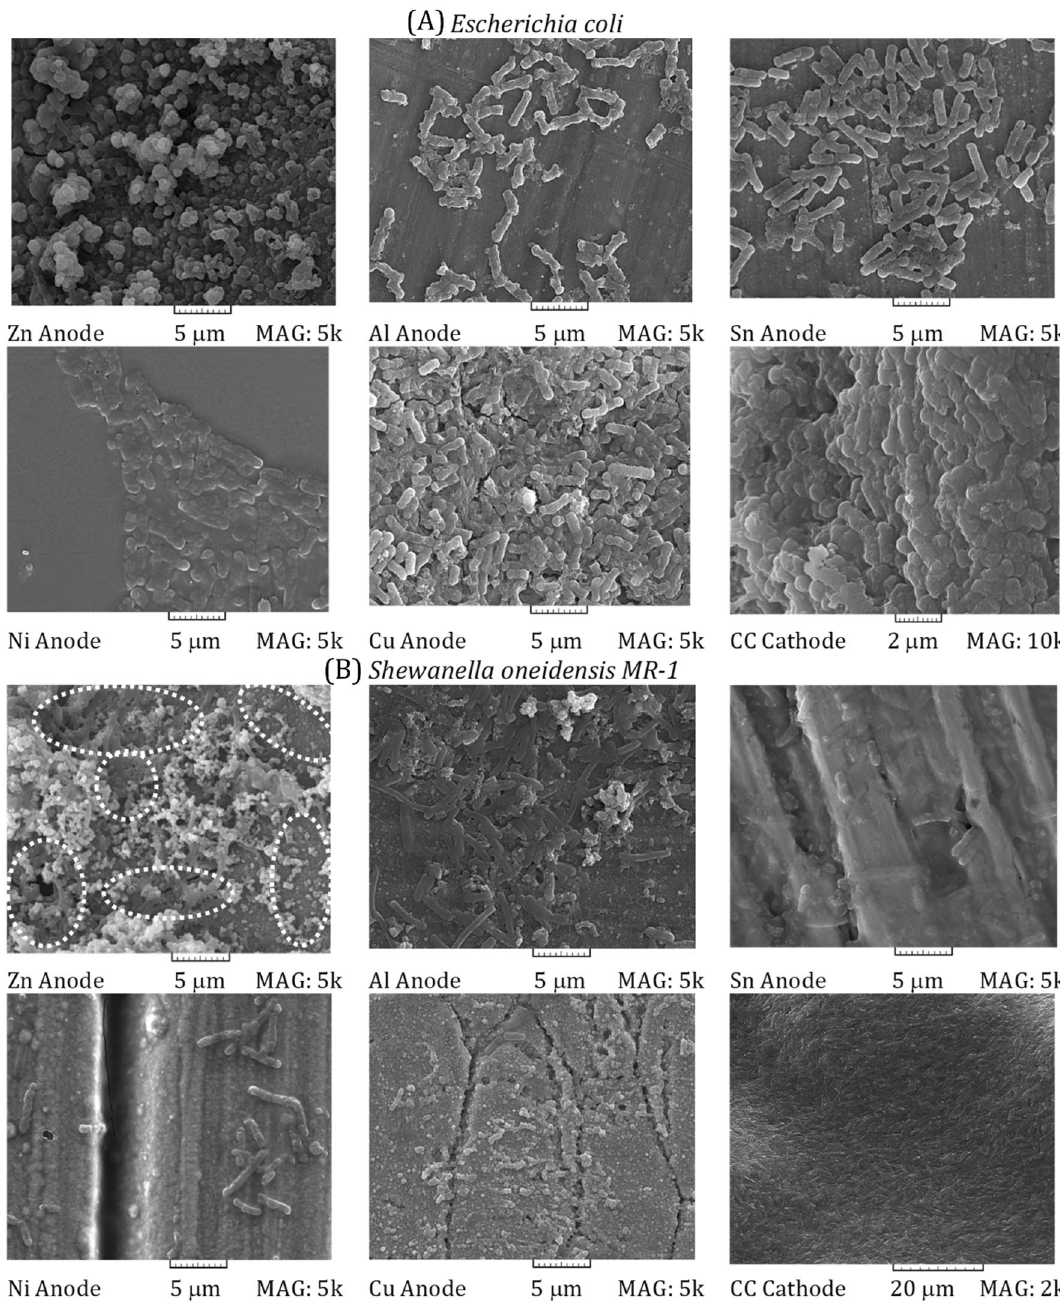
Figure 6. Scanning electron microscopy (SEM) images of the ( A ) Escherichia coli and ( B ) Shewanella oneidensis MR-1 biofilm on the anode and cathode surface areas of the microfluidic MFCs. The related information of each SEM image was